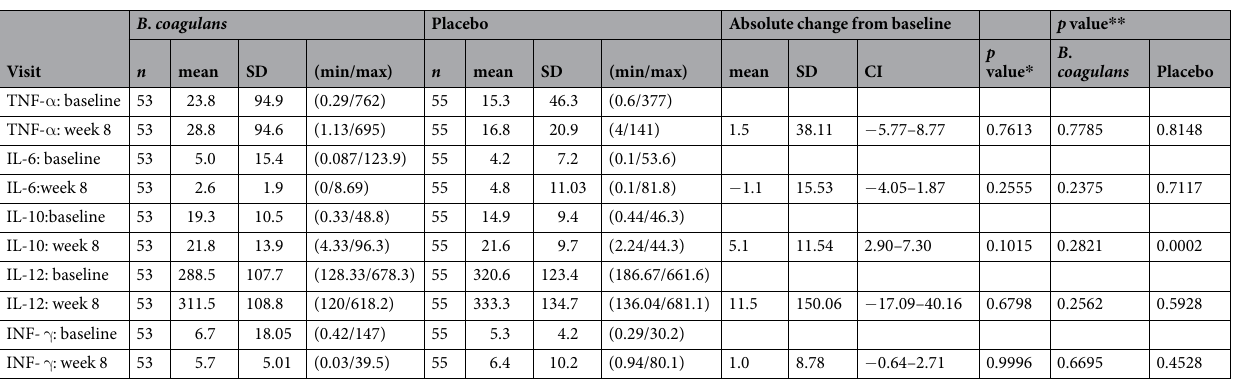
Table 2. Serum cytokine profile (TNF- α , IFN- γ , IL-6, IL-10 and IL-12) of participants. p value * : inter group (two sample t test). p value ** : intra group (two sample t test). n : number of patients. Values are represented in pg/mL (picograms per